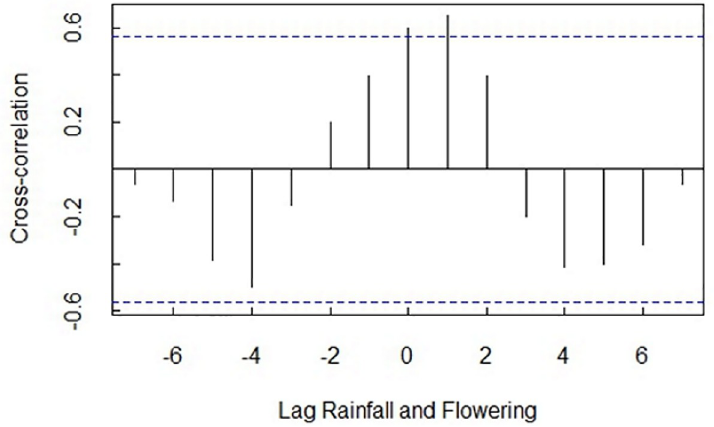
Fig 4. Correlogram indicating a prominent, moderately significant lead between flowering and rainfall at position